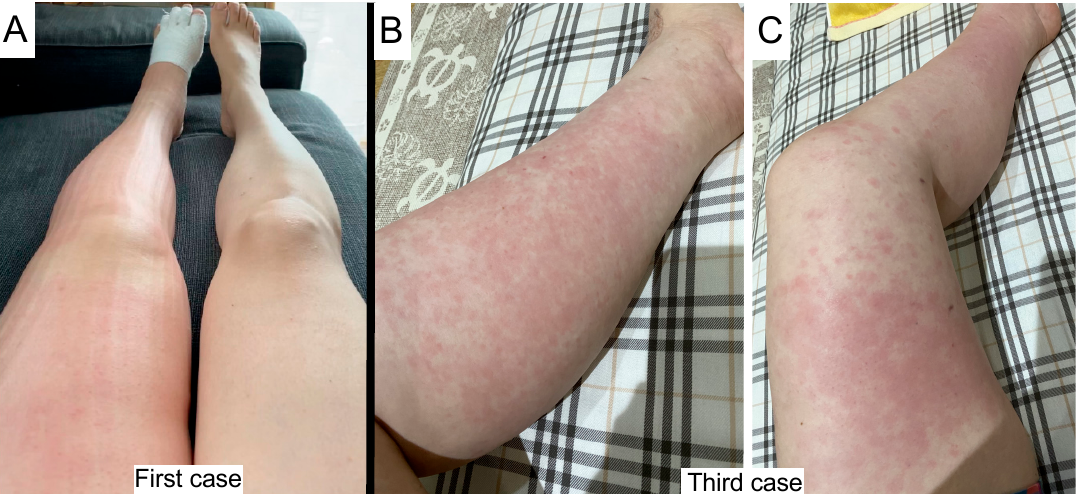
Figure 1. ( A ) The first case. A 52-year-old female with lymphedema of the lower left limb developed cellulitis at her lymphedema lesion 11 days after the first BNT162b2 mRNA vaccination. Mild redness in the lower left leg. Compression therapy by an elastic garment made wrinkles on the left leg, and an elastic bandage wrapped the left toe. ( B , C ) The third case. A 49-year-old female with lymphedema of the lower left limb developed cellulitis at her lymphedema lesion on the day of the second BNT162b2 vaccination. ( B ) Development of cellulitis on the lower leg. ( C ) Development of cellulitis on the entire lower limb.